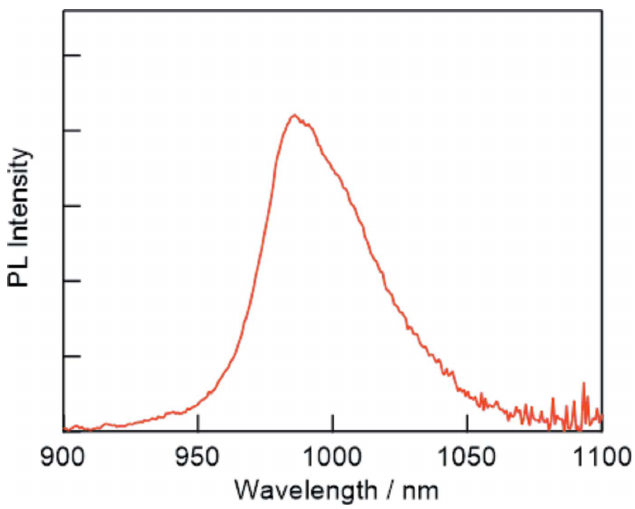
Figure 4 Near-infrared emission from Yb 3+ after treatment of the precursor crystals with a CsCl methanol solution.